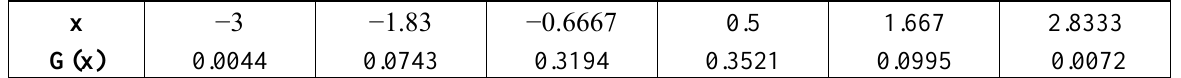
Table 5. Large values of Gauss function.